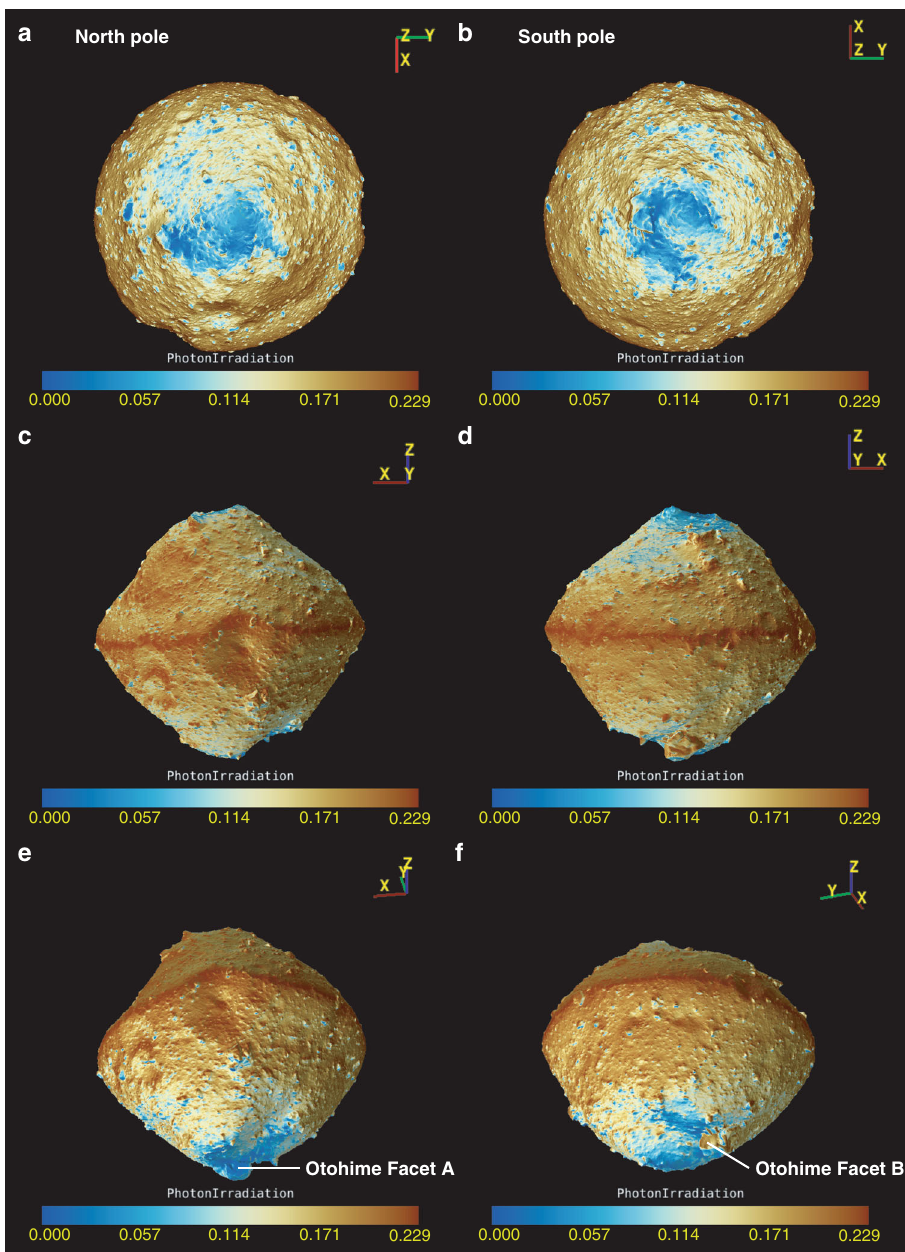
Fig. 4 Global distribution of solar photon dose averaged over one asteroidal year. This value is normalized by the photon dose experienced by a facet perpendicular to the Sun at 1 au away. Thus, the color bars show non-dimensional value. a , b are nadir views from the north and south poles. c , d are the views from (LAT, LON) = (0°, 90°) and (0°, 270°), respectively. e , f are the views from ( − 30°, 100°) and ( − 30°, 200°) to show Facets A and B of Otohime Saxum. Photon dose distribution shows lower irradiation for the polar regions. Otohime ’ s Facet A shows very low irradiation due to the hill just in front of